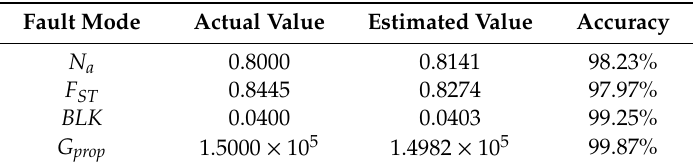
Table 4. FDI results for a full damage combination.